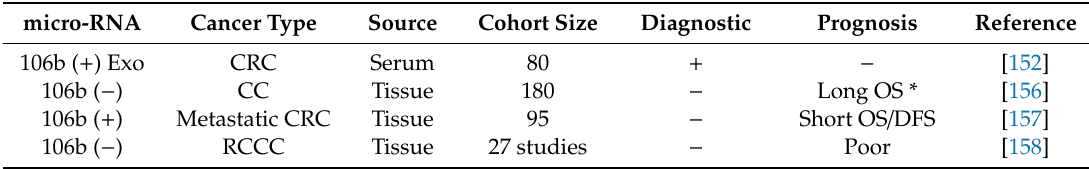
Table 8. Elevated ( + ) or reduced ( − ) miRNA-106b levels are shown, as are the cancer types, source of materials the miRNA was detected from and the patient cohort size. The negative or positive use of the technique in diagnostic or prognostic evaluation of patients are denoted by − or + , respectively. Exo, exosomal; RCCC, renal clear cell carcinoma; CC, colon cancer; CRC, colorectal cancer; OS, overall survival, DFS, disease-free survival; *, not statistically significant.